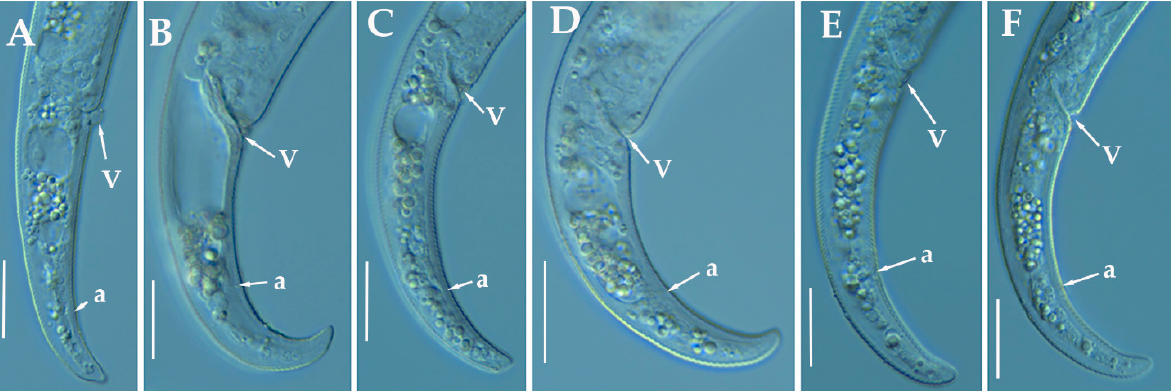
Figure 5. Light photomicrographs of Paratylenchus indalus sp. nov. female posterior regions ( A – F ). Scale bar: 20 μ m). (Abbreviations: a = anus; V = vulva). Table 3. Morphometrics of Paratylenchus indalus sp. nov. paratype females and other populations from Spain. All measurements are in μ m and in the form: mean ± s.d. (range).